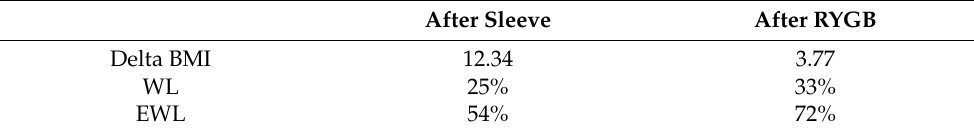
Table 4. Comparison of Delta BMI, %WL and %EWL before and after Roux-en-Y Gastric Bypass. After Sleeve After